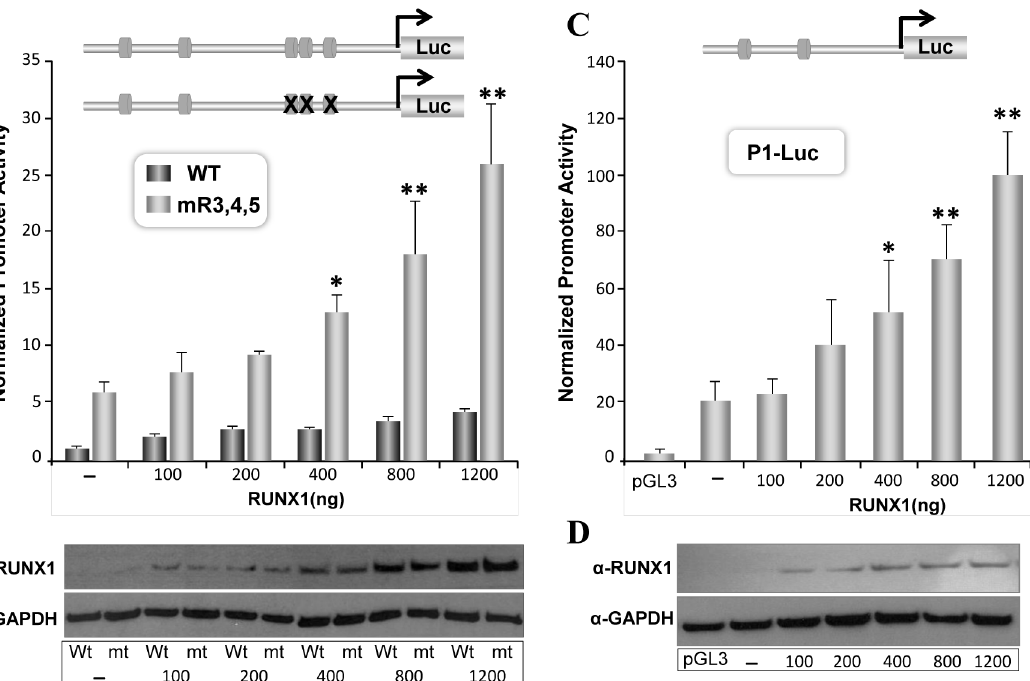
Fig 3. Mutation or deletion of RUNX motifs in the UTR enhances RUNX1 mediated transcriptional activity of the P1 promoter. A) Non-hematopoietic HeLa cells were transiently co-transfected with a fix amount (200ng) of either wild type or RUNX mutant promoter-reporter plasmids and increasing concentration (100-1200ng) of RUNX1 expression vector. Cells were harvested 18h later and luciferase activity was determined by dual luciferase assay system. Values were normalized with Renilla luciferase activity used as an internal control. Pooled values from at least four independent experiments performed in triplicate are presented in the bar graph along with the standard error of the mean. Asterisks indicate statistical significance between wild type and mutant promoter ( * p < 0.1, ** p < 0.01. B) Parallel plates of HeLa cells were transiently co-transfected exactly as described in (A) and harvested 18h later. Cell were directly lysed and equal amount of proteins were resolved by SDS-PAGE. Blots were probed with polyclonal RUNX1 antibody, strip and re-probed with mouse monoclonal GAPDH antibody. C) HeLa cells were co-transfected with P1-Luc and increasing concentrations of RUNX1 expression plasmid using nanojuice transfection reagent. Cells were harvested 18h later for luciferase activity. Normalized data pooled from four independent experiments are presented in bar graph. Asterisks indicate statistically significant increase in promoter activity in response to RUNX1 overexpression as determined by student t-test ( * p < 0.1, p ** < 0.01). D) HeLa cells were co-transfected with 200ng of P1-Luc and increasing concentrations of RUNX1 expression vectors. Cells were processed for western blot analysis 18h later and a representative blot is